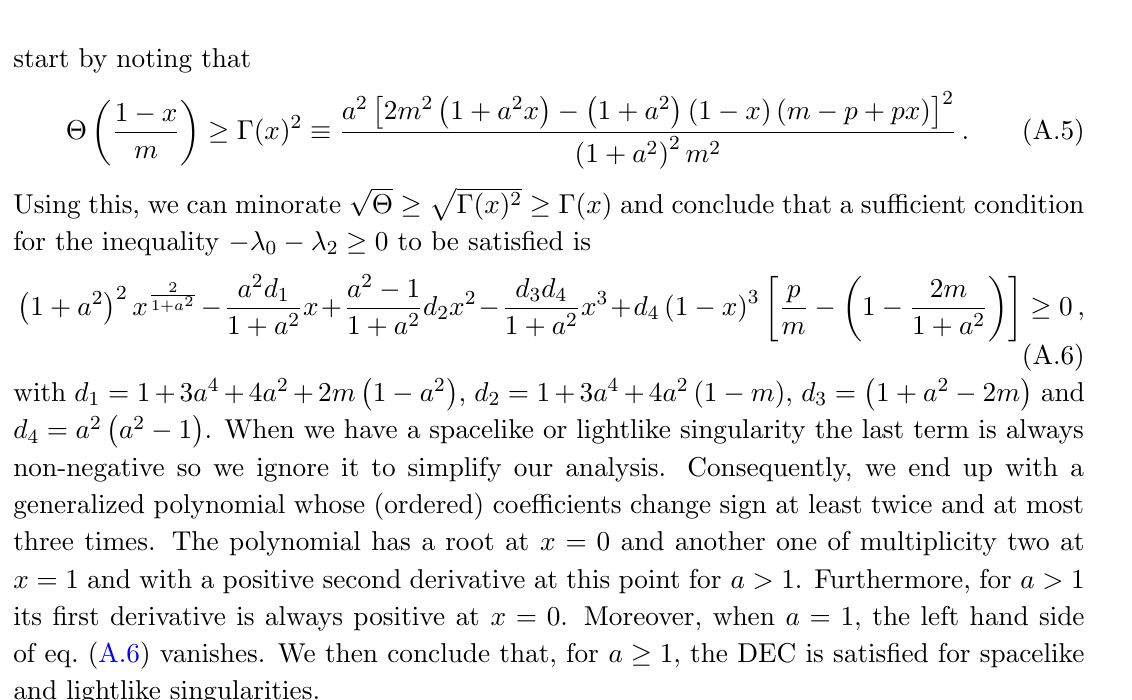
0 : 8 these curves coincide with those (cid:24) 0 : 8 (cid:24)